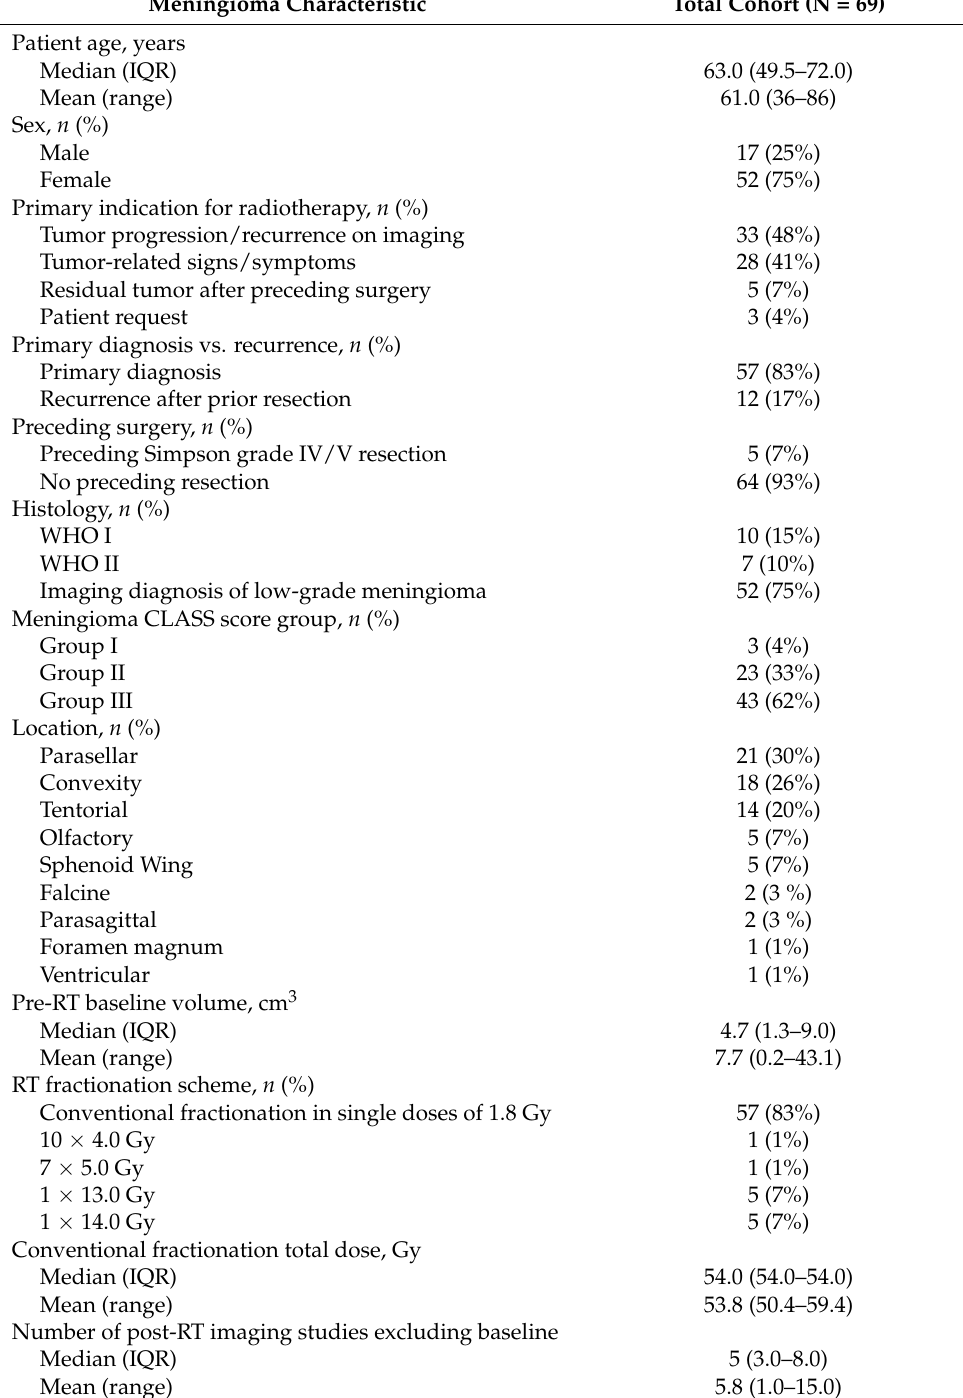
Table 1. Characteristics of treated meningiomas (N =